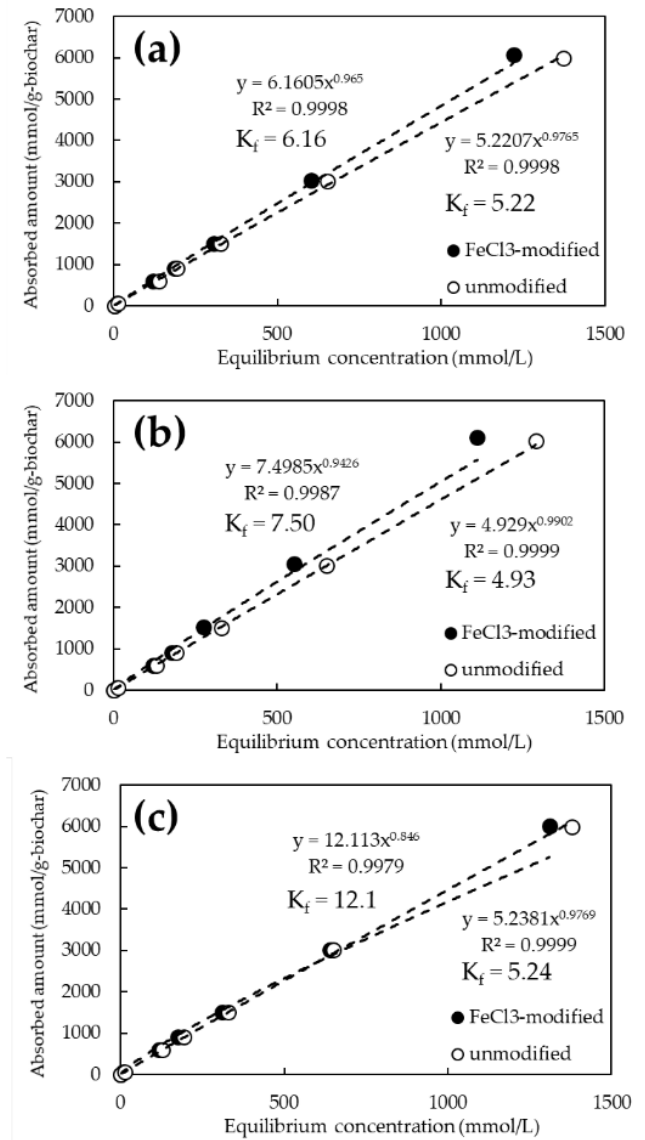
Figure 5. As(V) adsorption isotherms for FeCl 3 -modified and unmodified biochars at various pyrolysis temperatures. ( a ) Pyrolysis temperature: 600 °C; ( b ) Pyrolysis temperature: 800 °C; ( c ) Pyrolysis temperature: 1200 °C.